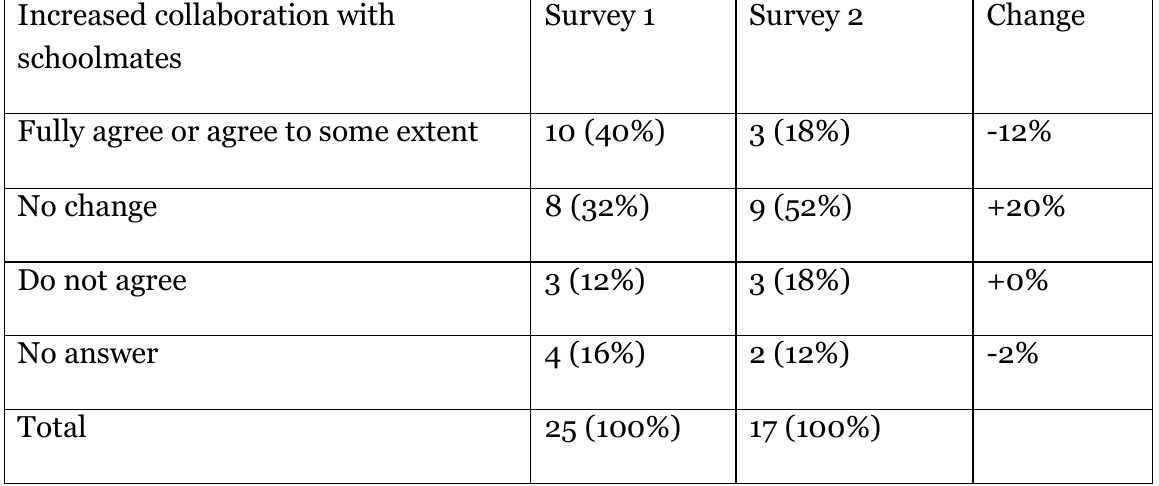
Table 2 Parents’ Perceptions of increased collaboration with